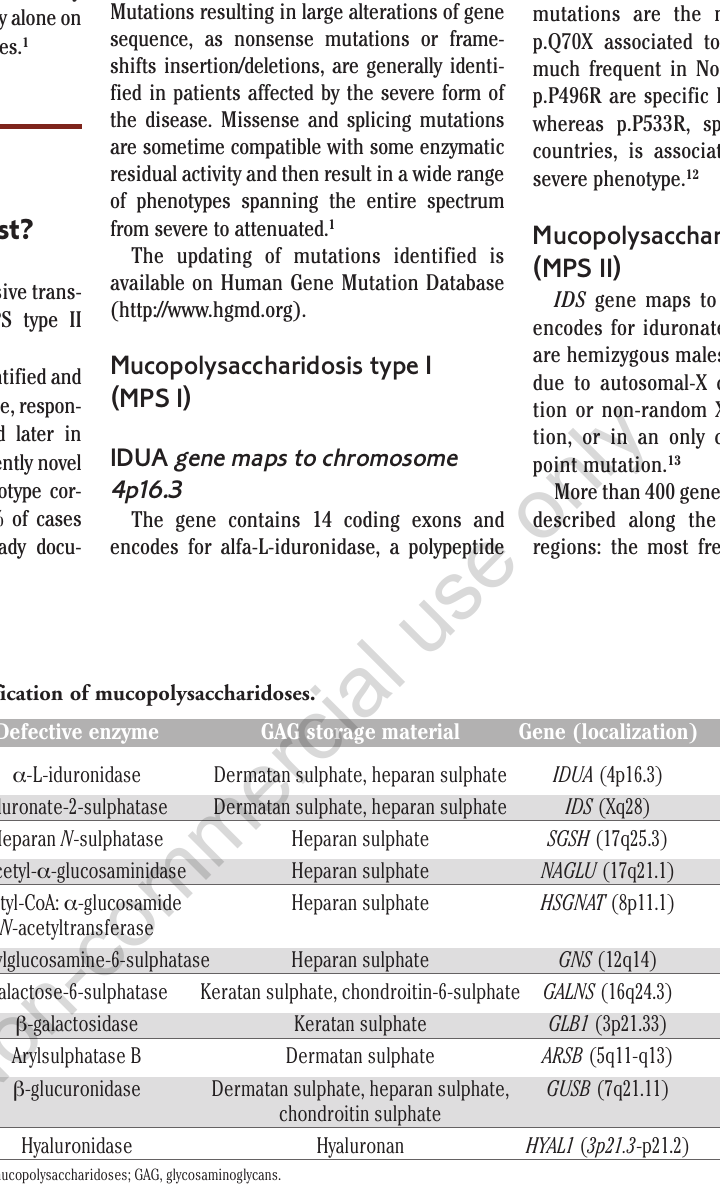
Table 2. Red flags: warning signs for early diagnosis of mucopolysaccharidoses. Most frequent signs and symptoms of onset Most severe forms Attenuated forms Age of onset Organomegaly N Heart valve disease Hernias Skeletal abnormalities Joint contractures Eye